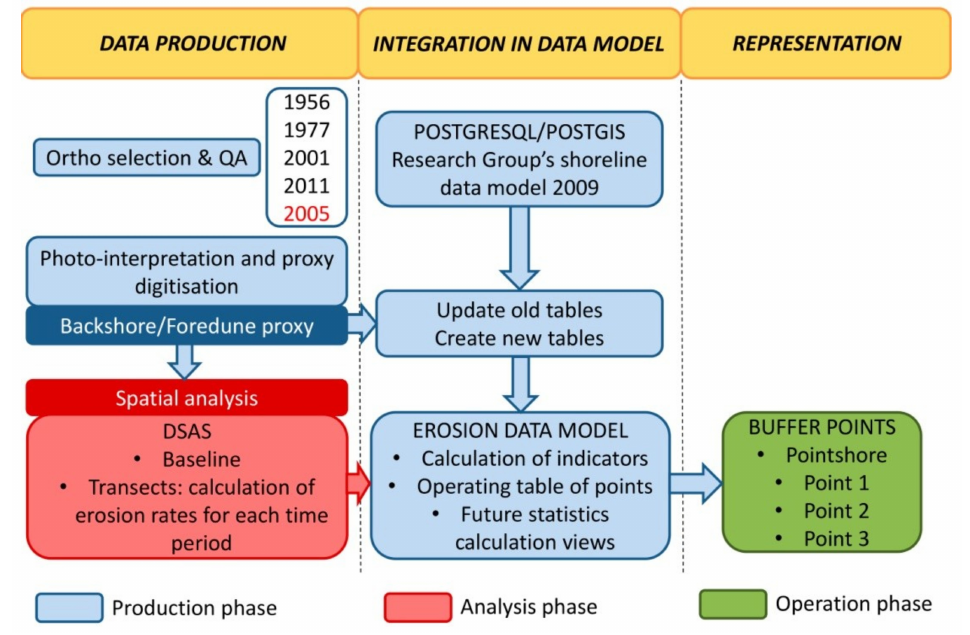
Figure 2. Phases of the methodological